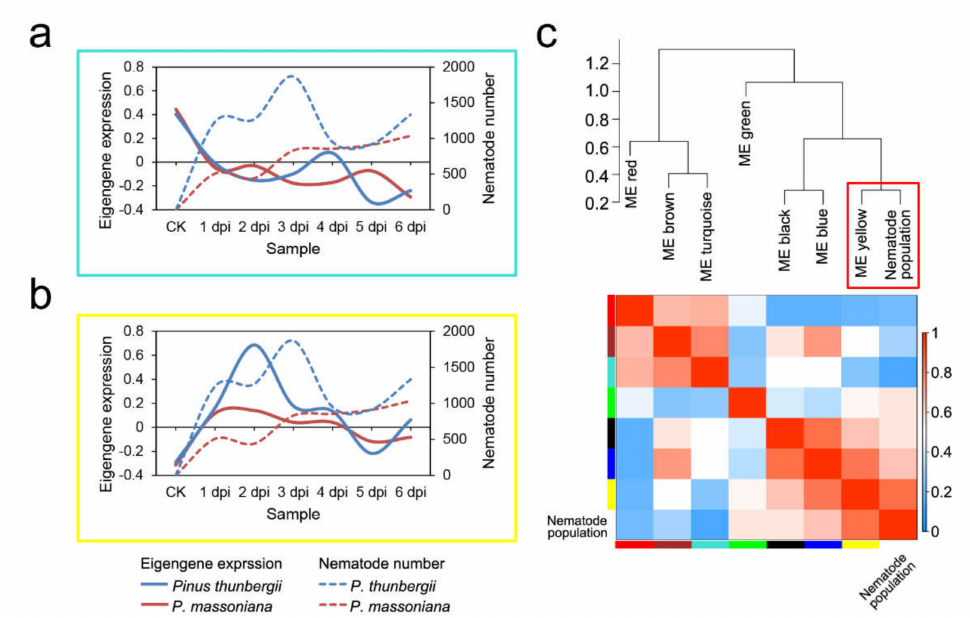
Figure 4. Module eigengene expression pattern and correlation. ( a ) Comparison of eigengene expression (y-axis) in the turquoise module across the samples (x-axis); ( b ) comparison of eigengene expression in the yellow module across the samples; ( c ) hierarchical clustering dendrogram and heatmap of the correlated eigengenes and nematode population. ME, module